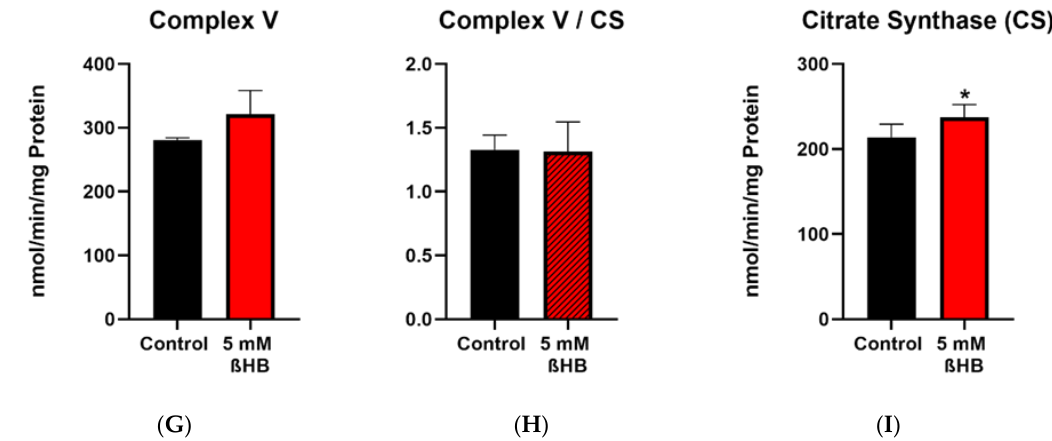
Figure 3. Graphs A – C , G , and I represent maximal enzymatic activities of the respiratory chain complexes I–IV, ATP–synthase (complex V) and citrate synthase. The graphs ( D – F , H ) depict normalized ratios of the enzymatic activities of the respiratory chain to the enzymatic activity of citrate synthase–the mitochondrial marker enzyme. * p < 0.05 ( n = 3–4). Data are shown as mean + SD.